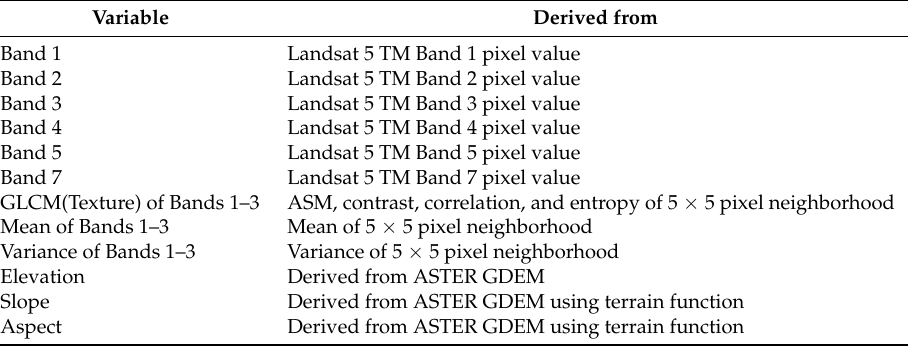
Table 1. Description of the utilized explanatory